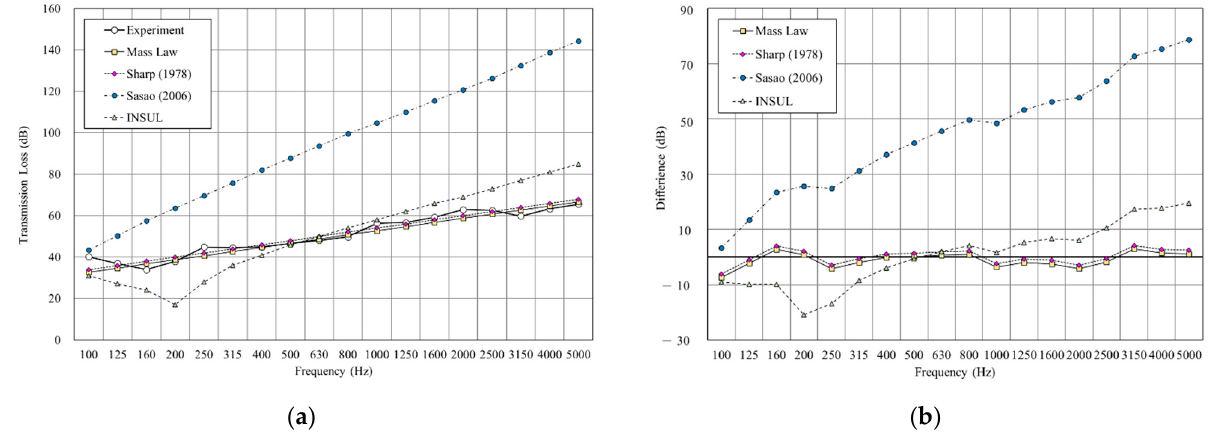
Figure 13. Comparison between experimental and predicted results of the double wall with 50 mm glass wool (B5). ( a ) The sound insulation performance of experiment and prediction. ( b ) The RMSE results of different prediction models.